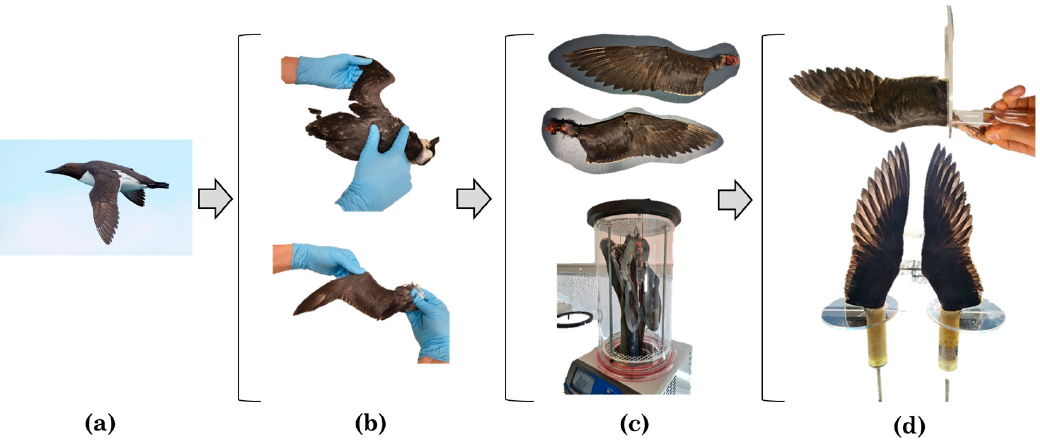
Figure 1. Wing preparation process: ( a ) Selection of the bird Common Guillemot ( Uria aalge ) [14], ( b ) Obtaining the wing, ( c ) mounting and freeze-drying process, ( d ) Fixation of the wings. The wing in the defined load shape was preserved following a freeze-drying method utilized to preserve specimens for teaching collections (see Shoffner in 2013) [15]. Our freeze dryer consists of a refrigerated specimen chamber, a refrigerated condenser and a